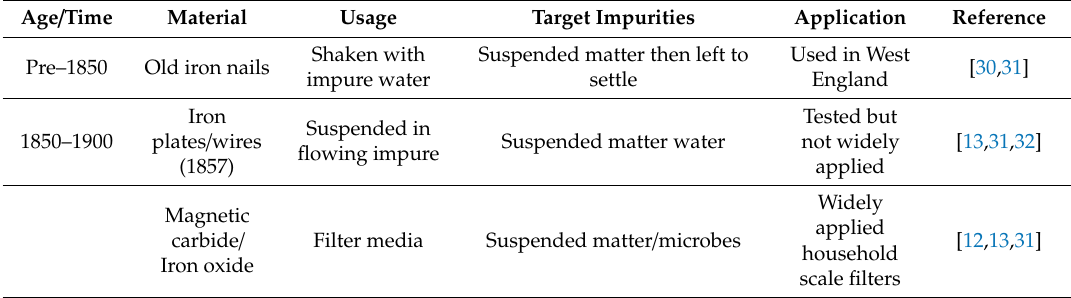
Historical application of metallic iron in water treatment (modified from Mwakabona et al.